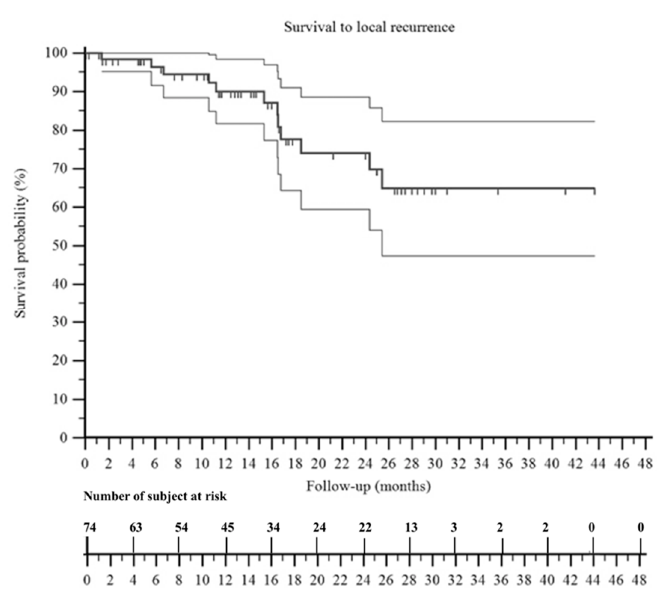
Figure 4. A Kaplan–Meier curve shows the survival to local recurrence of the patients included in this series. It was 74% at 2 years and 64% at 3 years. The two surrounding thin black lines represent the 95% confidence intervals.